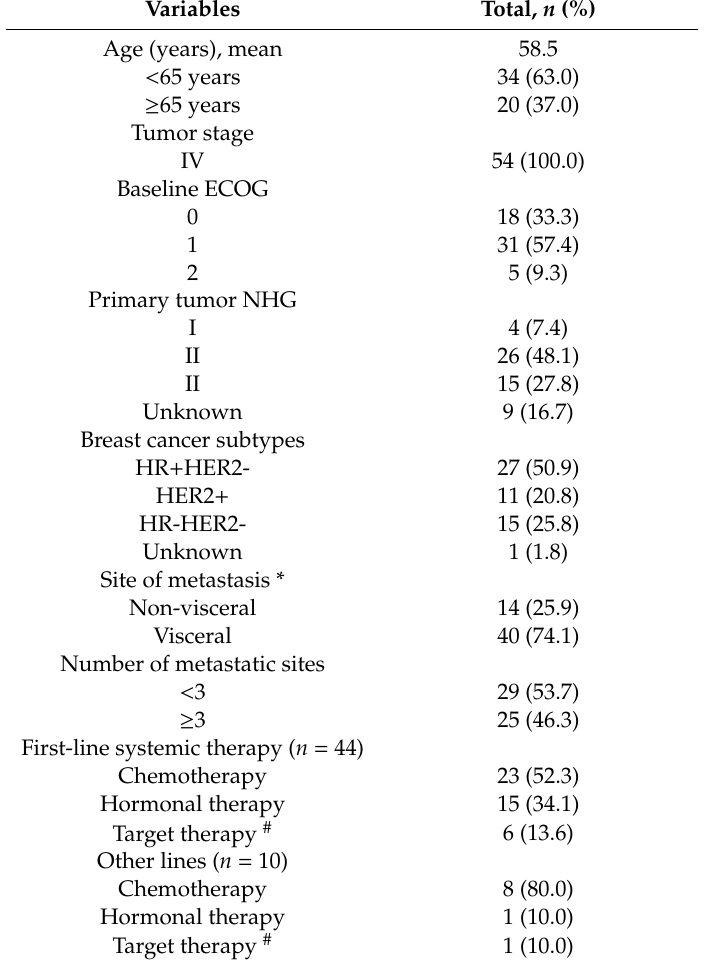
Table 1. Patient characteristics ( n =